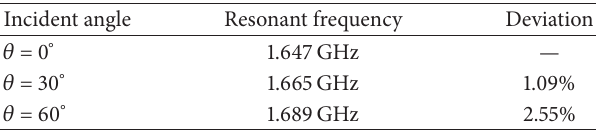
Table 3: The resonant frequency deviation of proposed FSS at TE- polarized.